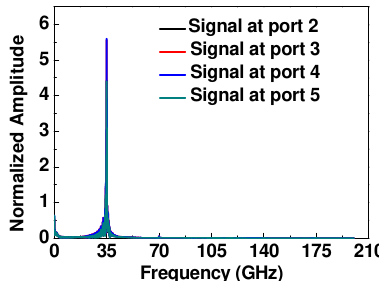
Figure 8. Spectrums of the signals plot of the four output ports. Figure 7. Input and output signals plot of the novel amplifier at 35 GHz. Figure 7. Input and output signals plot of the novel amplifier at 35 GHz.